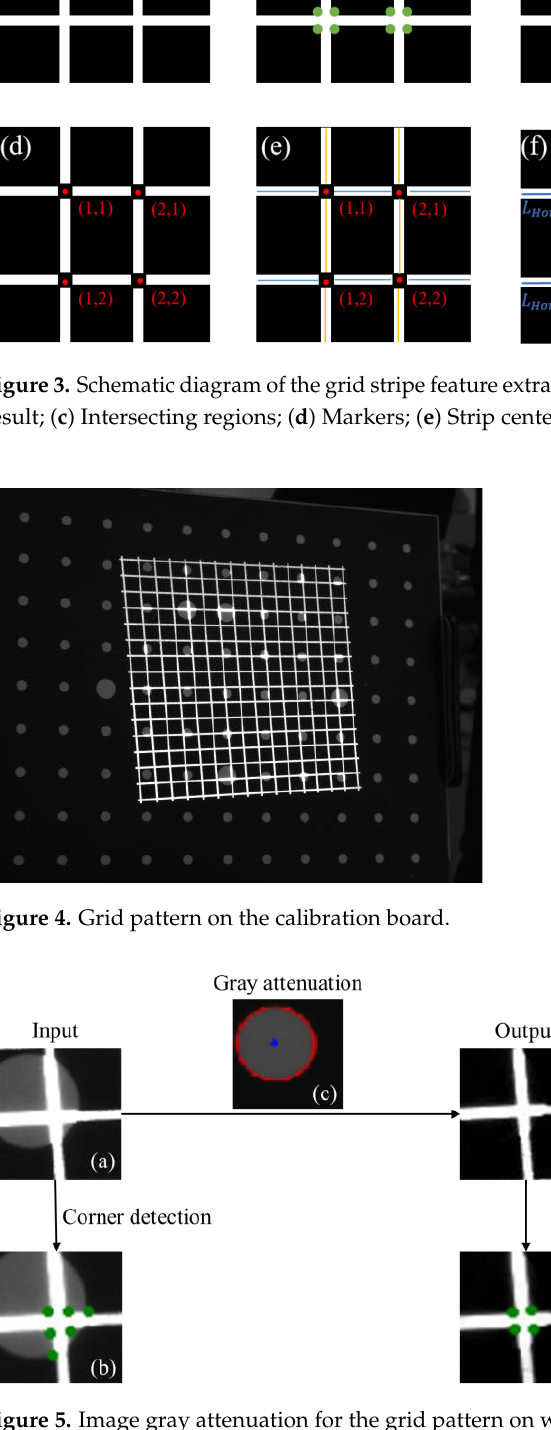
Figure 3. Schematic diagram of the grid stripe feature extraction. ( a ) Input image; ( b ) Corner detection result; ( c ) Intersecting regions; ( d ) Markers; ( e ) Strip centers; ( f ) Horizontal and vertical stripes.